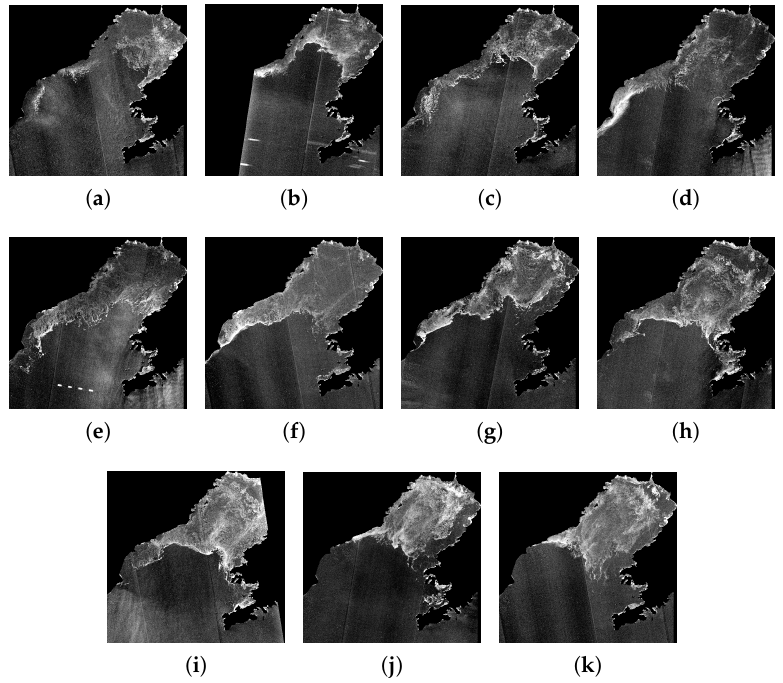
Figure 9. RADARSAT-2 ScanSAR Wide mode HV polarization channel SAR imagery: ( a ) 2 january 2013; ( b ) 6 January 2013; ( c ) 9 January 2013; ( d ) 16 January 2013; ( e ) 23 January 2013; ( f ) 26 January 2013; ( g ) 2 February 2013; ( h ) 9 February 2013; ( i ) 12 February 2013; ( j ) 16 February 2013; ( k ) 19 February 2013; c (cid:13)